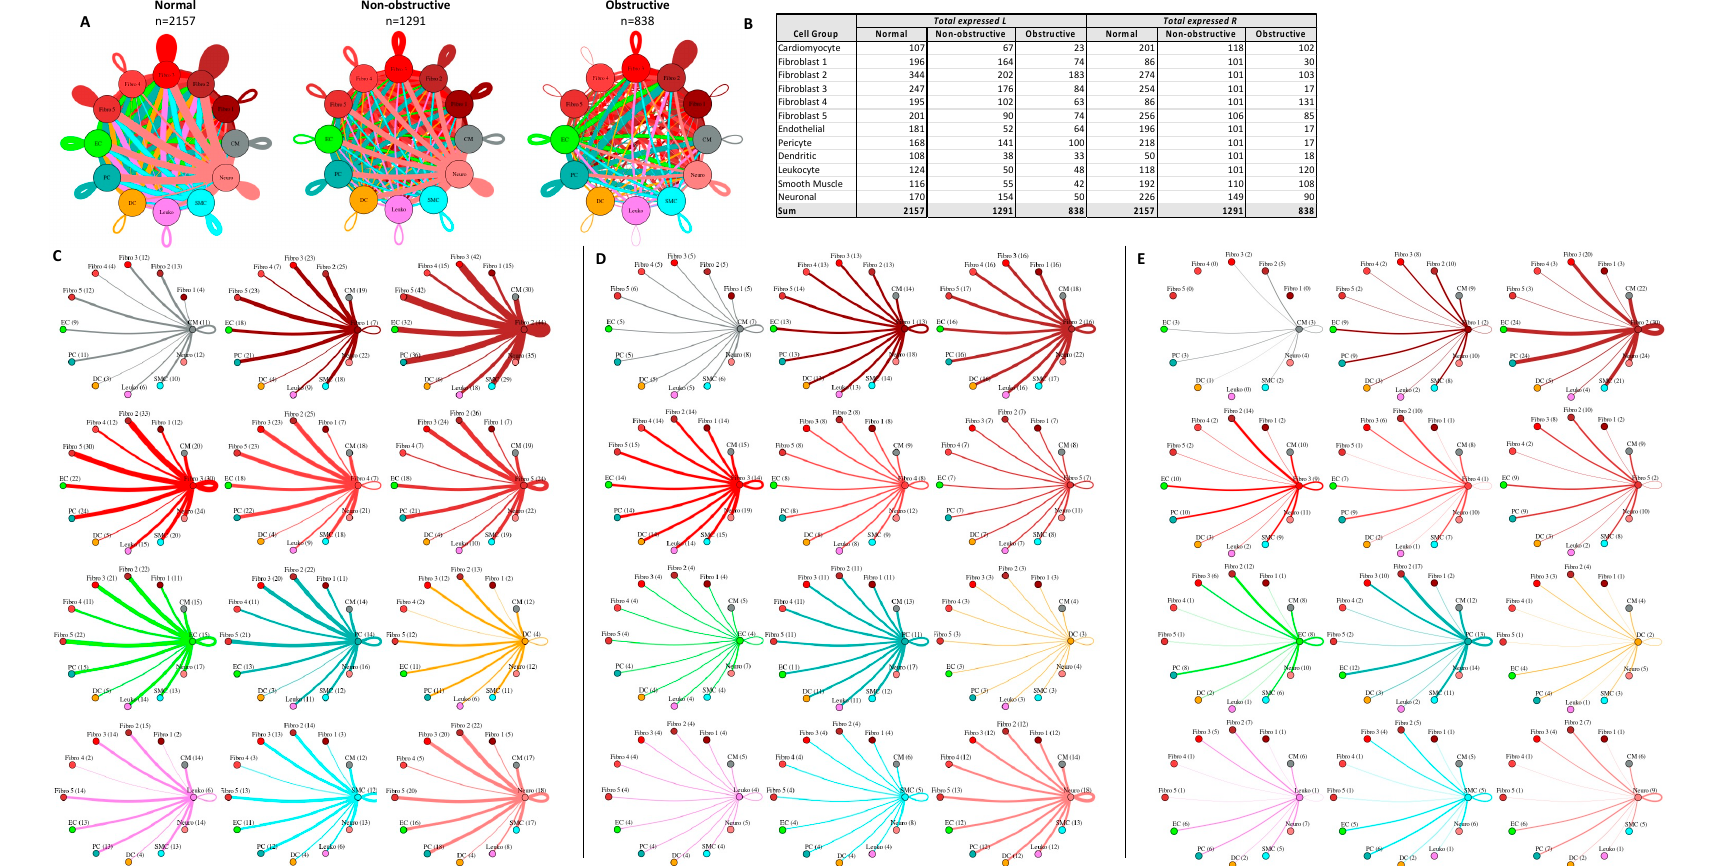
Figure 7. Cell–cell communication networks between fibroblast subtypes and other heart cell types in normal control, nonobstructive HCM, and obstructive HCM conditions. ( A ) Comparison of normal (left), nonobstructive (middle), and obstructive HCM (right) communication networks. Line color indicates ligand broadcast by the cell population with the same color. Lines connect to cell types that expressed cognate receptors. Line thickness is proportional to the number of uniquely expressed ligand–receptor pairs. Loops indicate communication within a cell type. ( B ) Quantity of ligands and receptors in expressed ligand–receptor pairs described by cell type and condition (normal, nonobstructive HCM, or obstructive HCM). ( C – E ) Cell–cell communication networks broken down by cell type and fibroblast cluster in normal control ( C ), nonobstructive ( D ), and obstructive ( E ) conditions. Figure formatting follows panel A. Numbers indicate the quantity of uniquely expressed ligand–receptor pairs between the broadcasting cell type (expressing ligand) and receiving cell type (expressing receptor). Cardiomyocyte subtypes also demonstrate diversity in their intercellular interactions in normal and HCM tissue, as previously reported [13,14]. To understand how these in- teractions compare and contrast in nonobstructive and obstructive HCM, we analyzed the L–R pair gene expression for all cardiomyocyte subtypes in conjunction with all other cell types (Figure 8). As with the general population and the fibroblast subtype interaction networks, in the cardiomyocyte subtype interactome there was a stepwise decrease in L– R pairs from normal (n = 4854) to nonobstructive (n = 3836) to obstructive (n = 2294) HCM.